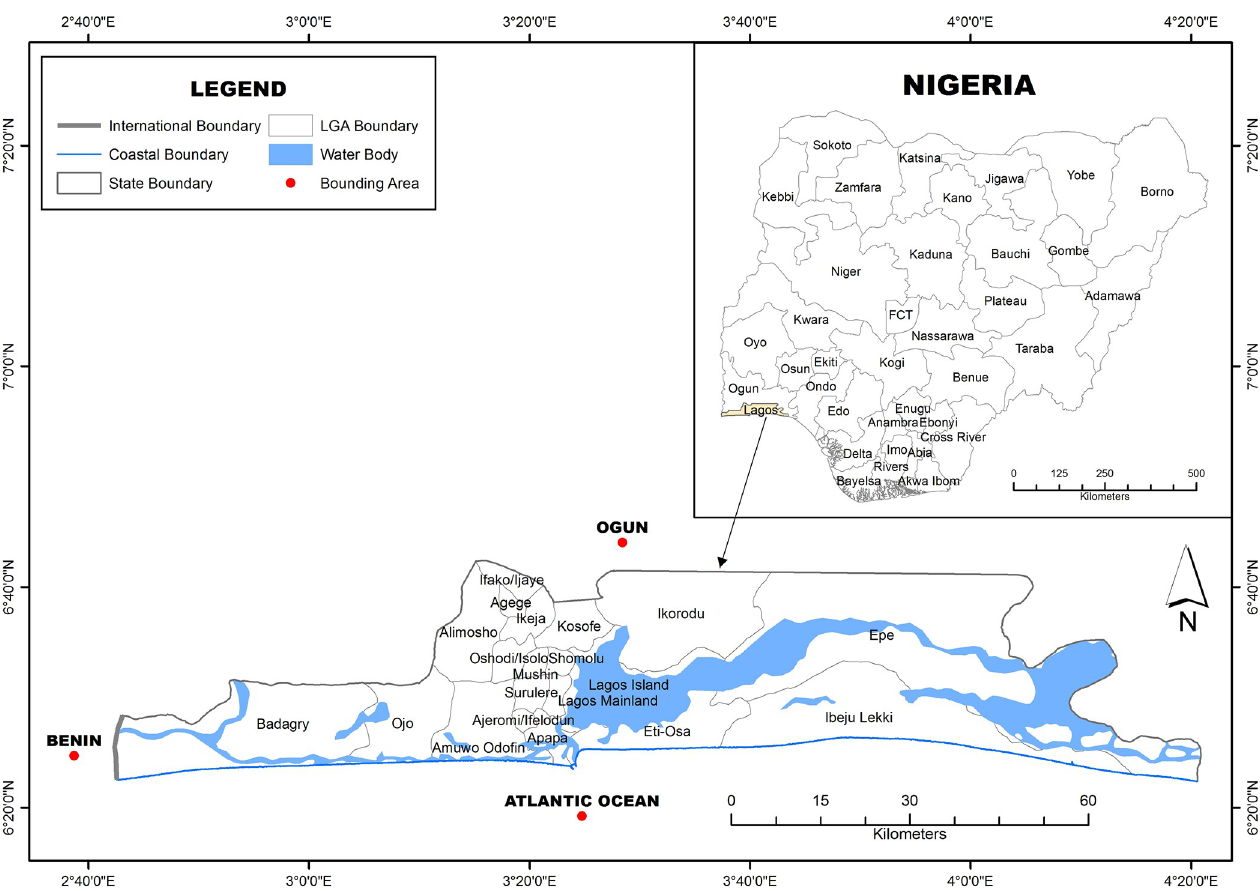
Fig 2. Map of Lagos with that of Nigeria inset. Source: Produced by the authors from Landsat Image Data obtained from United States Geological Survey (USGS) database at www.earthexplorer.usgs.gov.